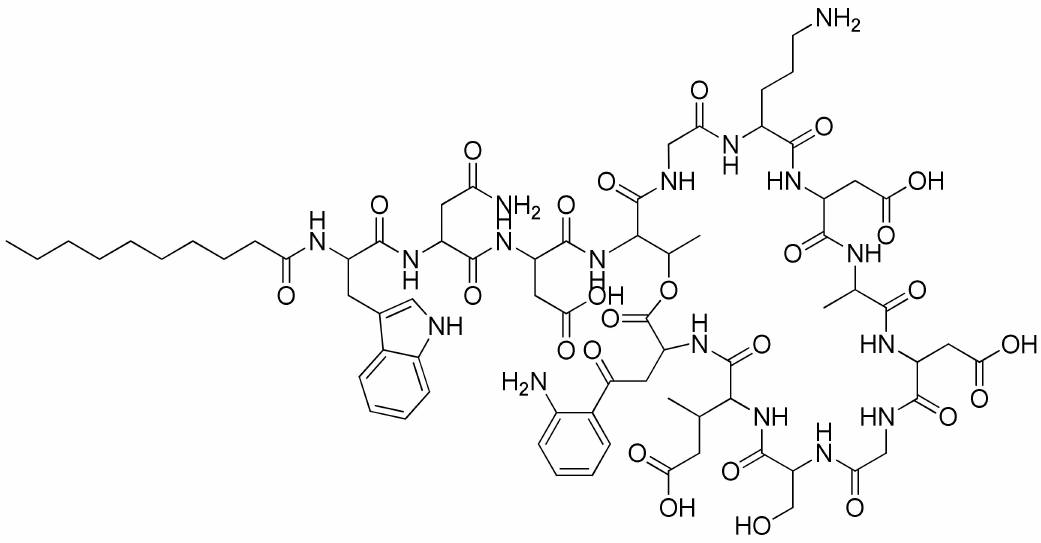
Figure 1. Chemical structure of